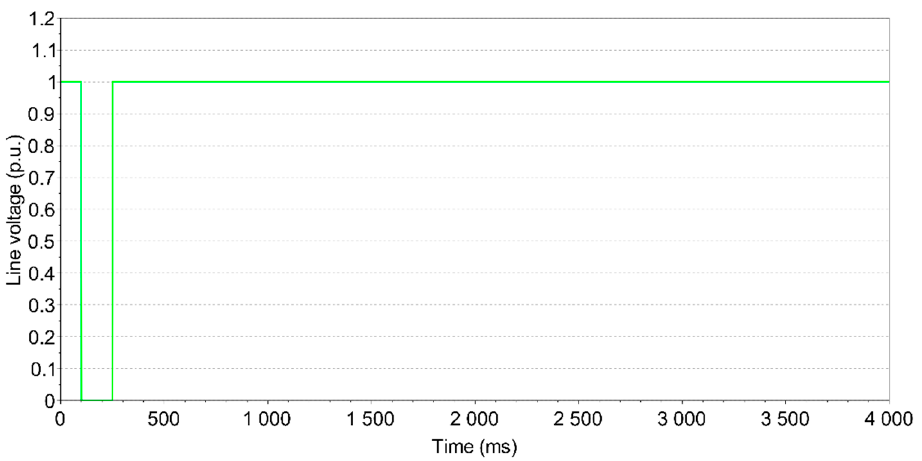
Figure 15. Line-to-line voltage (p.u.) at the induction generator terminals.